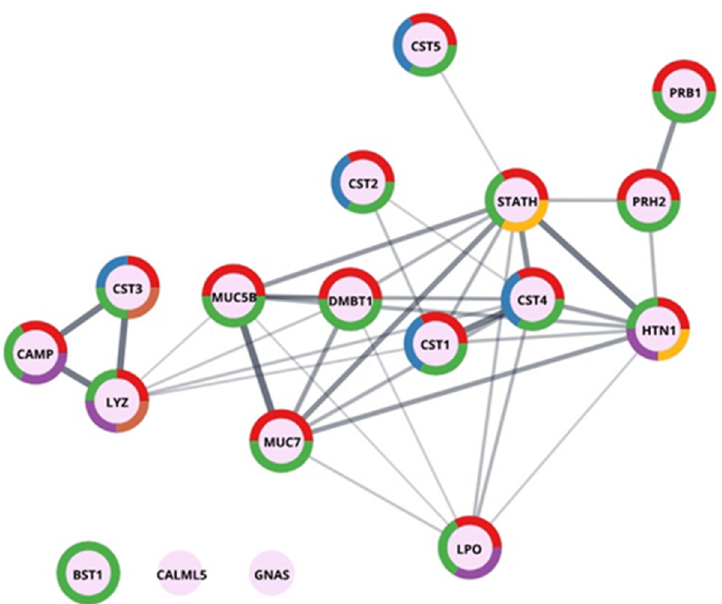
Figure 5. Graphic presentation of GO enrichment in the category—salivary proteins for sialolith1. The colours depicted in the circles correspond accordingly to Uniprot keywords enrichment: red— secreted, blue—thiol protease inhibitor, green—signal, purple—antimicrobial, brown—amyloid, yellow—biomineralization.